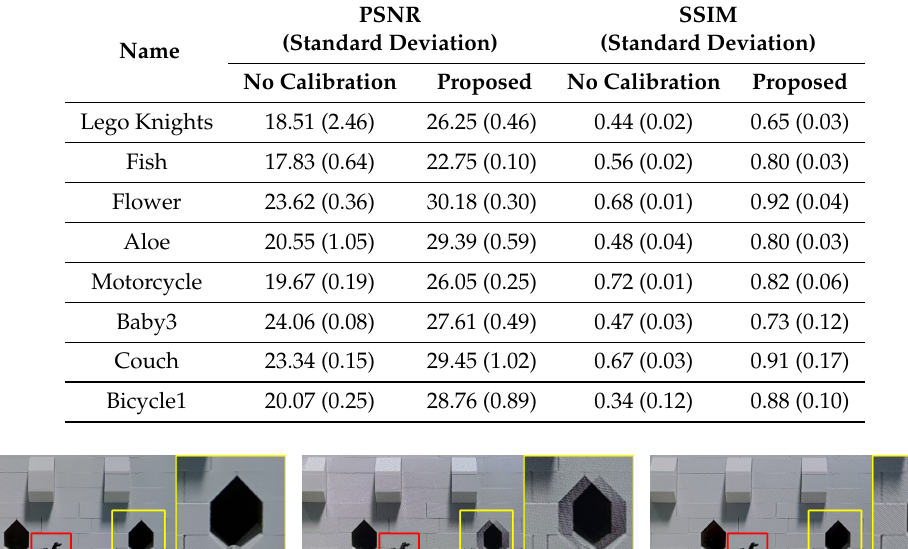
Table 4. Visual quality assessment. The shown numbers are the mean and maximum deviations (in parenthesis) of the PSNR and the SSIM index over four display instances.